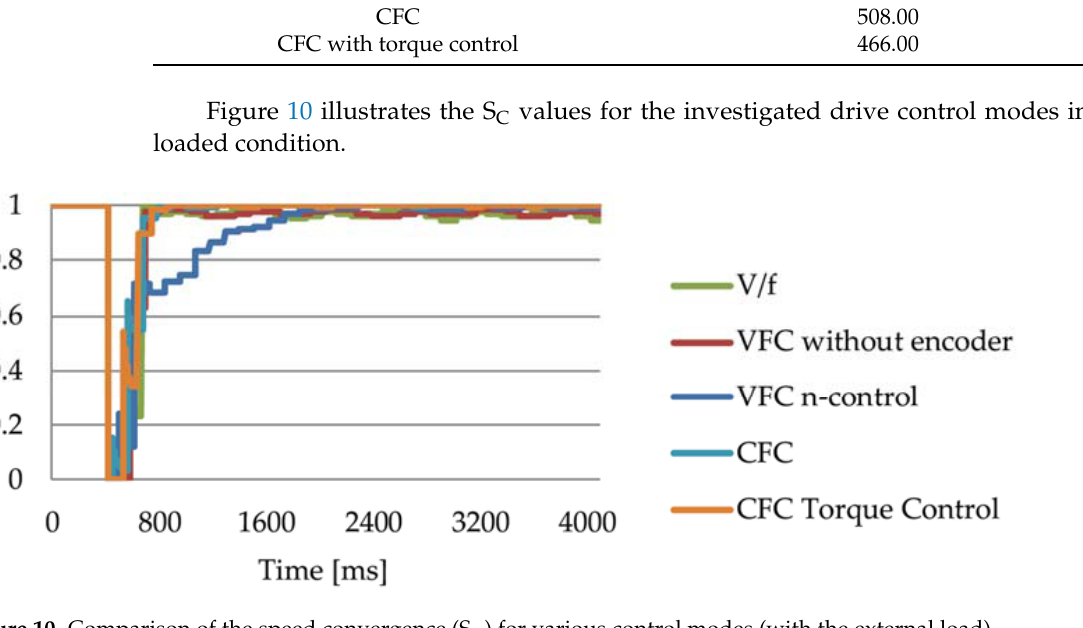
Figure 10. Comparison of the speed convergence (S C ) for various control modes (with the external load).